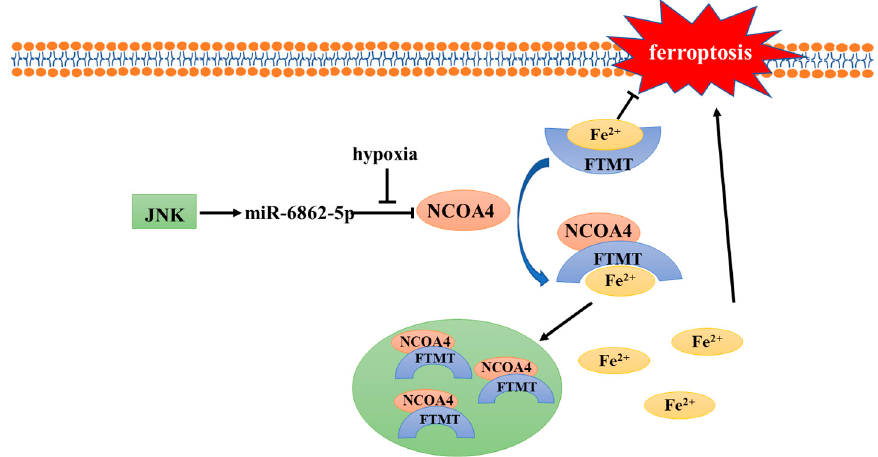
Figure 1. Mechanism of NCOA4 regulation under hypoxia.